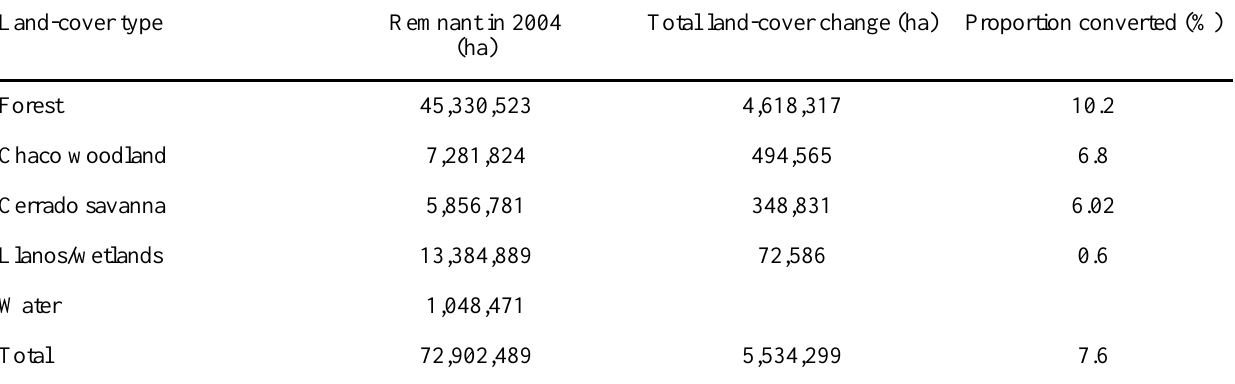
Table 2. Summary of total historical land-cover change in eastern Bolivia stratified by four major vegetation types or